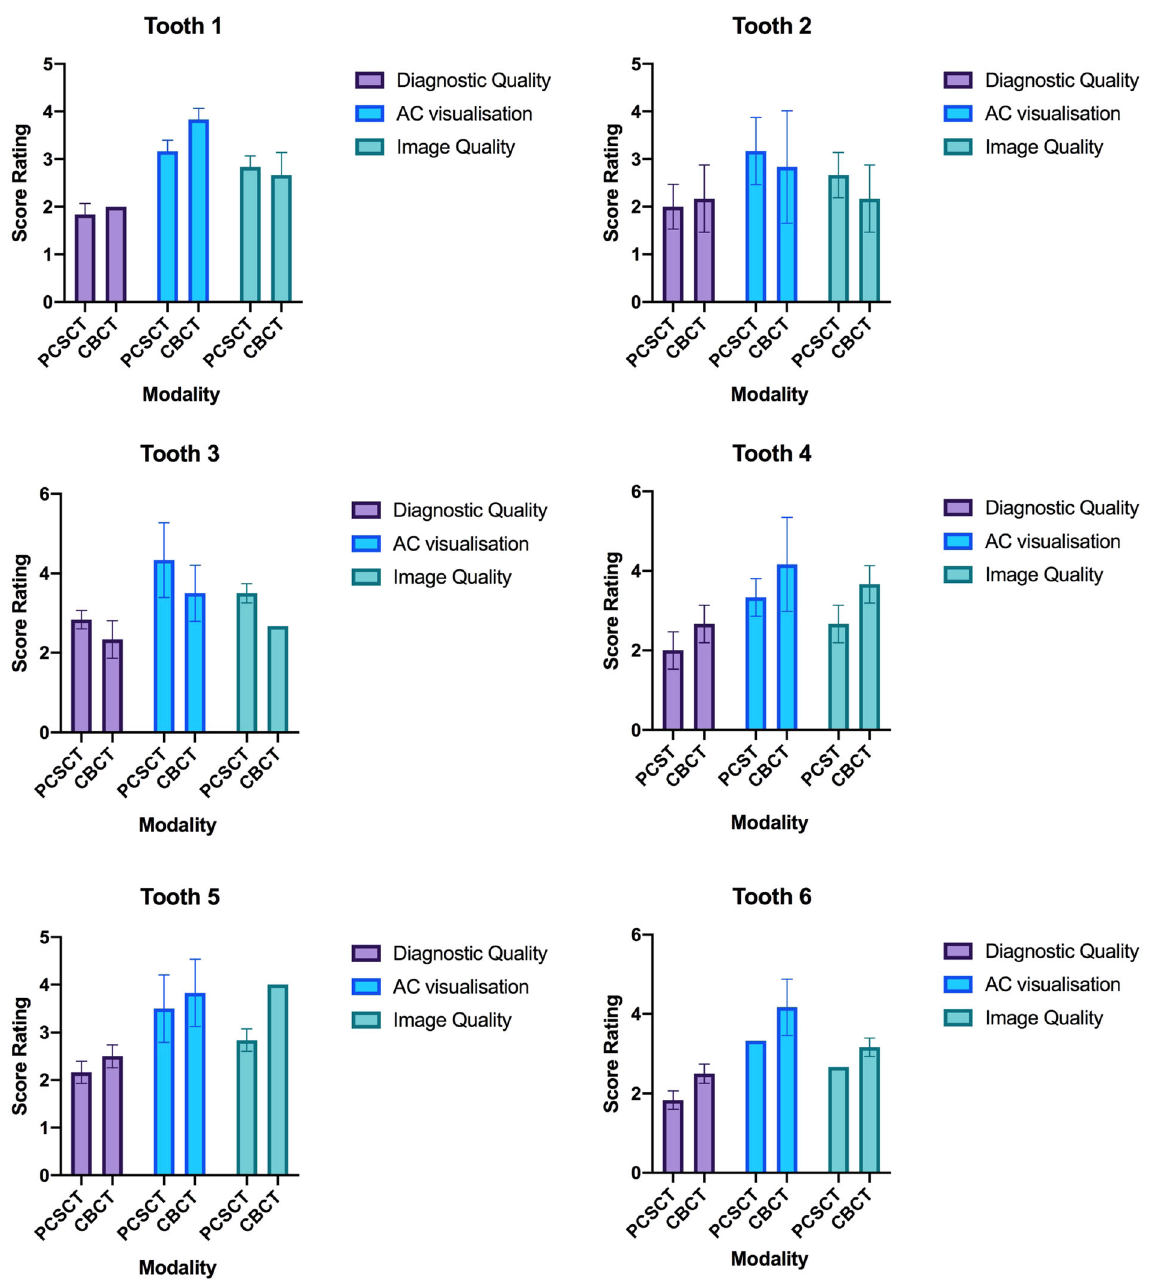
Fig. 2 Graphical representation for AC visualisation in teeth 1 – 6. The error bars represent the difference in the scores of the two